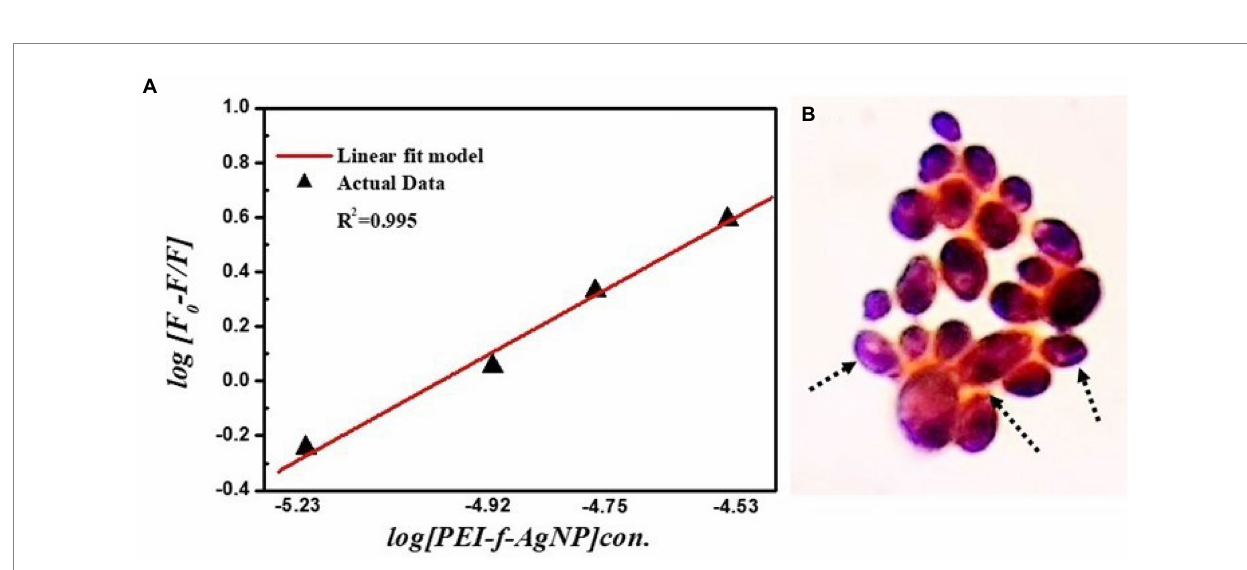
FIGURE 8 (A) Binding constant (Kb) and number of binding sites (n) for PEI-f-Ag-NP with C. albicans ; (B) Schematic depicts adsorbed PEI-f-Ag-NPs on the surface of C. albicans